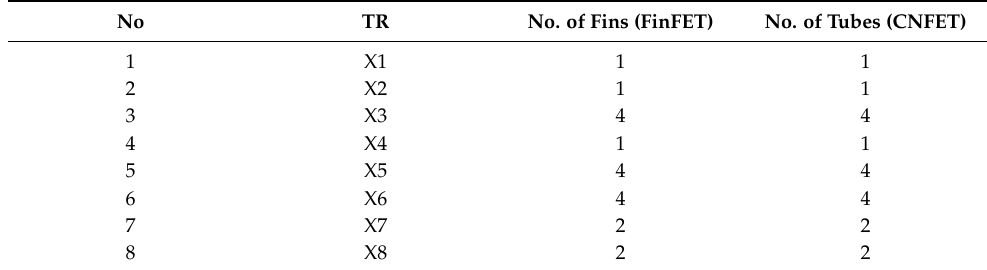
Table 2. Size of FinFET and CNFET in SE 8T